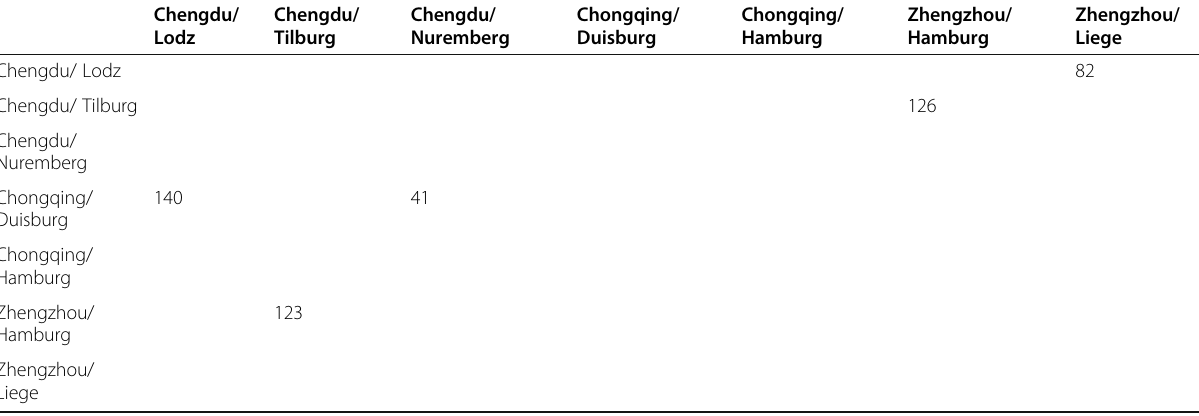
Table 3 European part of empty container transportation scheme (FEU) Chengdu/